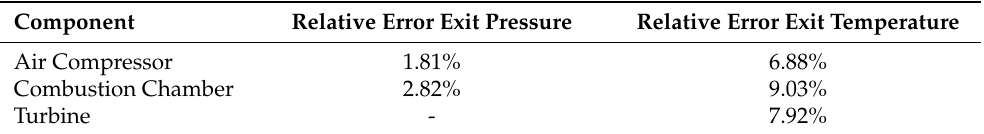
Table 4. Relative errors of the turboshaft